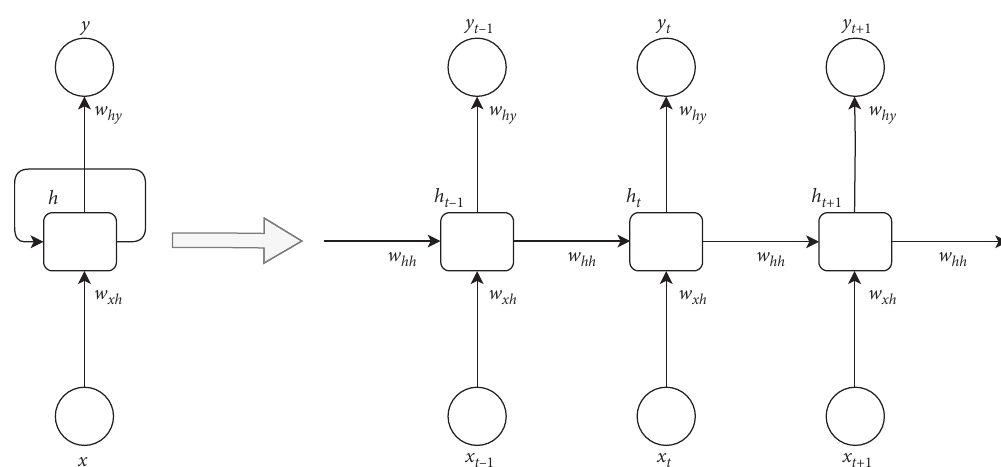
xh : weight matrix between input and